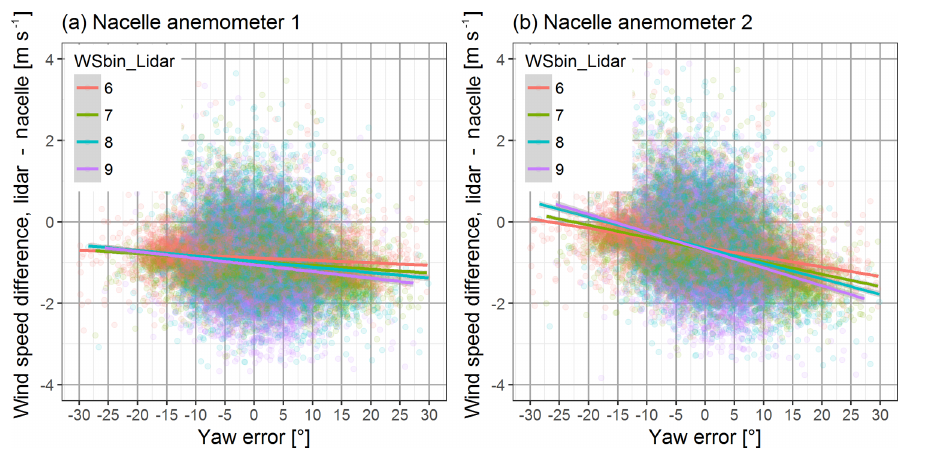
Figure 8. Wind speed difference between a ground-based lidar measuring in front of the turbine and the cup anemometers on the nacelle. The lines represent linear regressions for the respective wind speed bin (WSbin). Both 1min wind speed measurements behind the rotor are influenced by the yaw error.